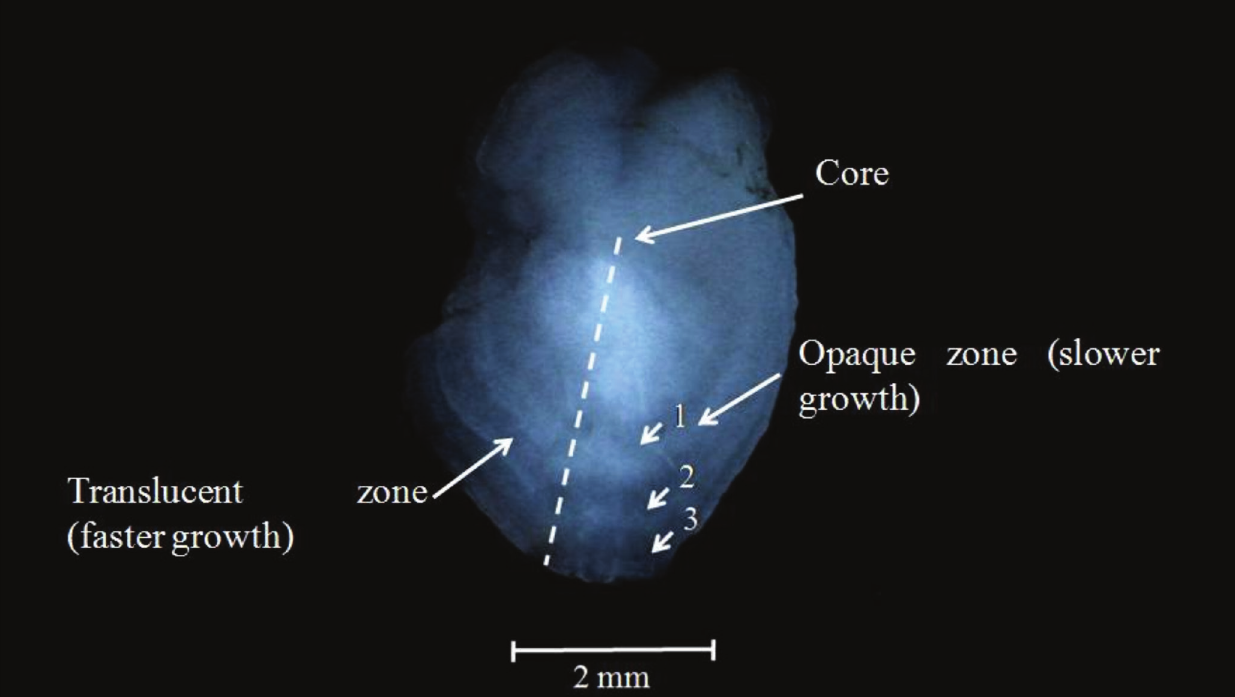
Fig. 2. The left otolith of a male Piaractus mesopotamicus that was collected in the headwaters of the Cuiabá River. Three annuli are marked (arrows), and the reading axis indicated (dashed